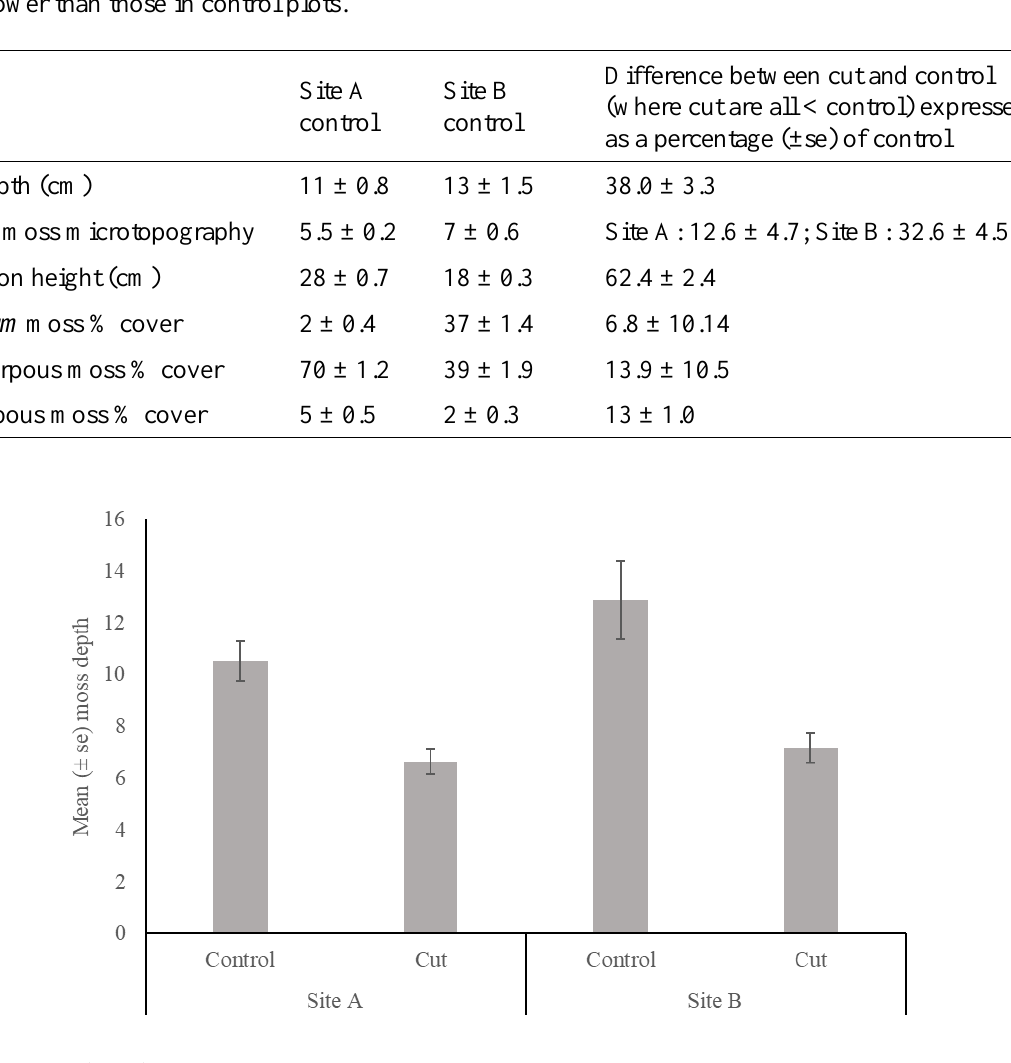
Figure 2. Mean (± SE) moss depth for cut and control plots on Site A and Site